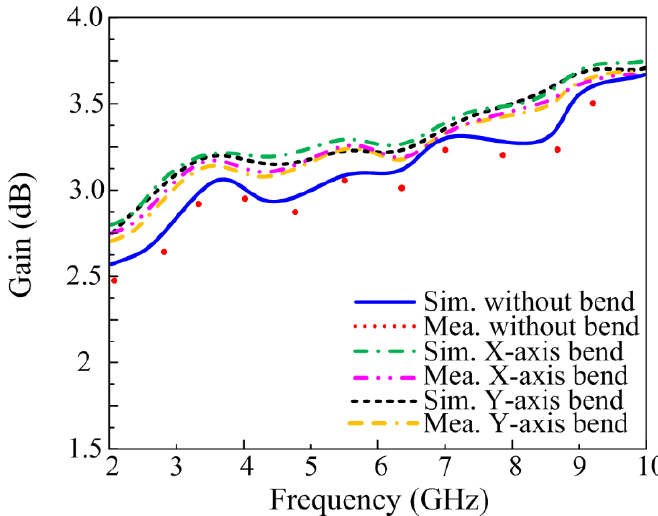
Figure 14. Figure 13. Gain of the proposed work for conformal and non-conformal scenarios